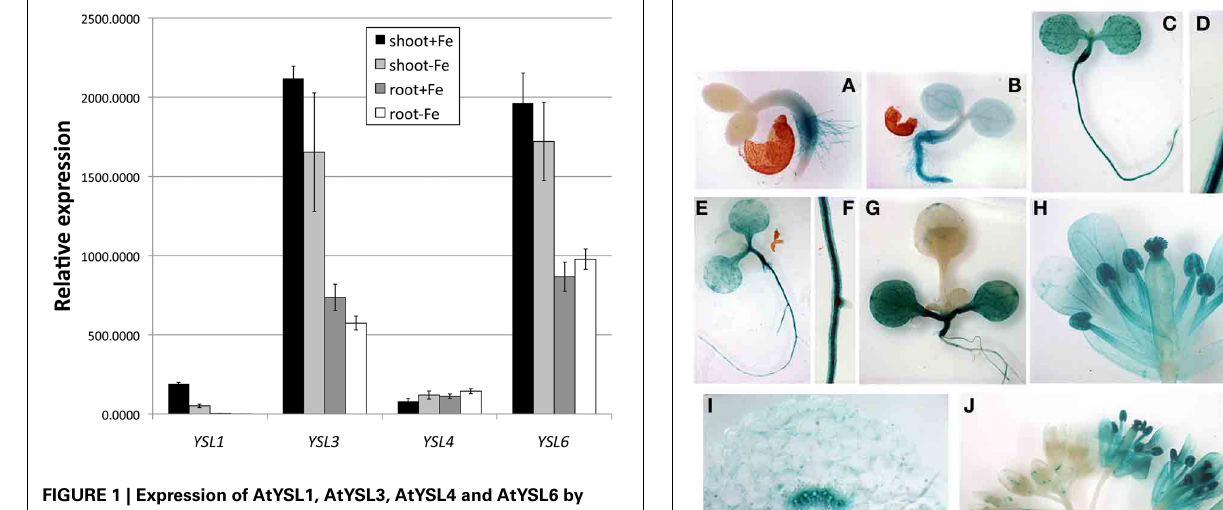
FIGURE 1 | Expression of AtYSL1, AtYSL3, AtYSL4 and AtYSL6 by quantitative RT-PCR. Plants were grown on MS medium for 10 days and then transferred to MS and MS lacking iron for 5 days. mRNA levels were quantified in both shoots and roots.